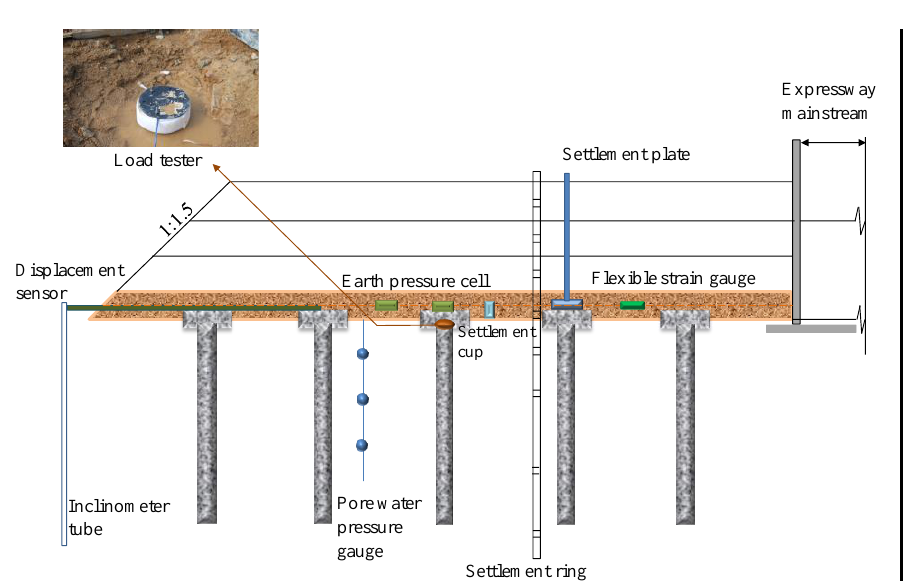
Figure 8. Schematic diagram showing monitoring system for GRPSE system.